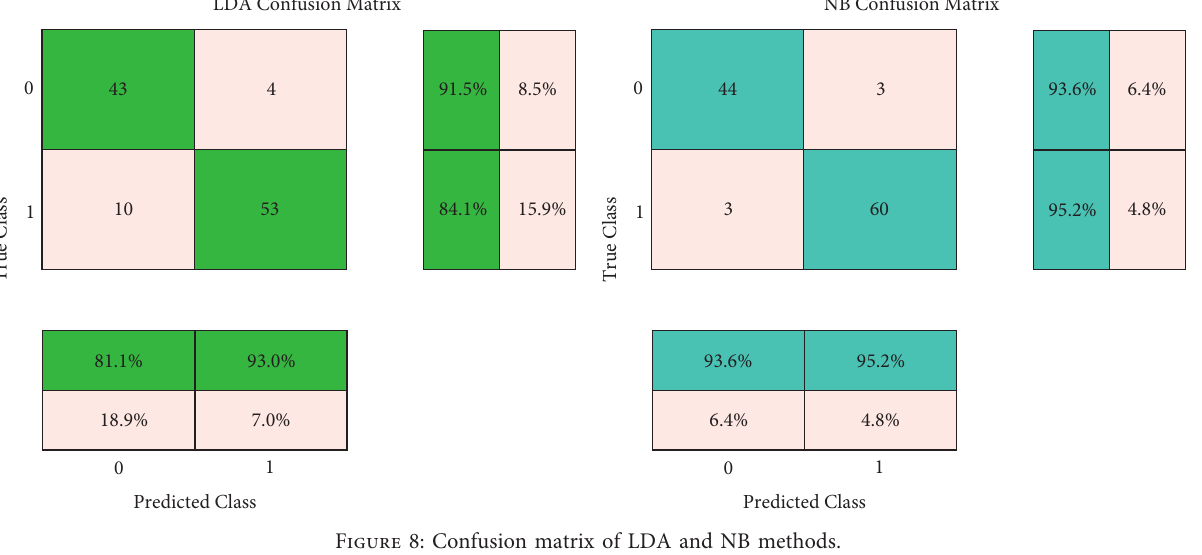
Figure 7: Confusion matrix of KNN and SVM methods.